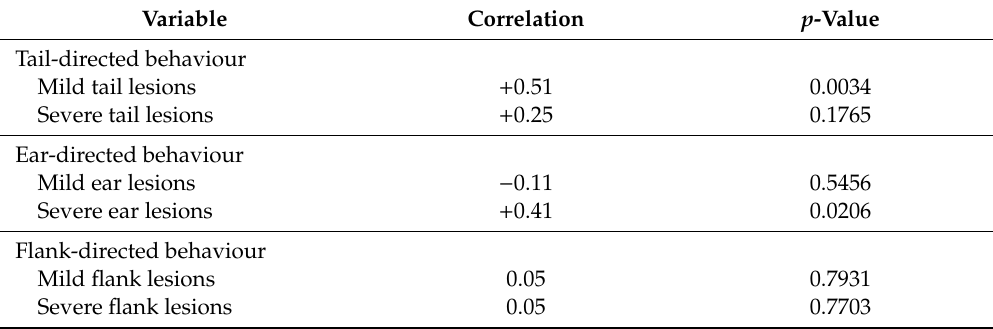
Table 3. Correlations between damaging behaviours observed during a 5 min period and the prevalence of finisher pigs with associated lesions on 31 farrow-to-finish pig